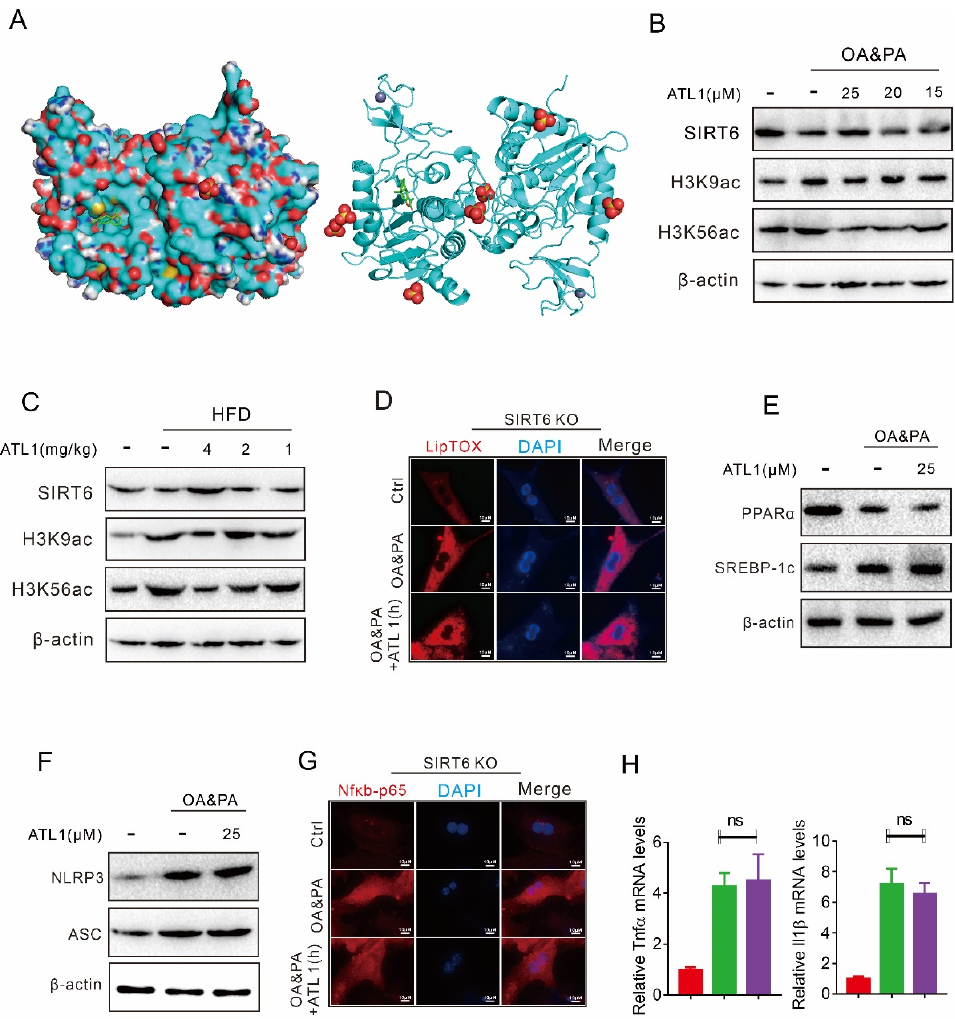
Figure 5. Hepatic SIRT6 mediates the protective effects of ATL I treatment against lipid disorder and inflammation response. ( A ) Molecular docking analysis showed a perfect binding between SIRT6 and ATL I. ( B ) ATL I treatment significantly increased the expression of SIRT6, H3K9ac, and H3K56ac in MPHs. ( C ) ATL I treatment significantly increased the expression of SIRT6, H3K9ac, and H3K56ac in mouse livers. ( D ) LipidTOX assays indicated that ATL I treatment failed to alter the lipid deposition in SIRT6-deficient MPHs. ( E ) ATL I treatment failed to alter the expression of PPAR α and SREBP-1c in SIRT6-deficient MPHs. ( F ) ATL I treatment failed to decrease NLRP3 and ASC protein levels in SIRT6-deficient MPHs. ( G ) ATL I treatment failed to decrease the nuclear Nf κ B-p65 levels in SIRT6-deficient MPHs. ( H ) ATL I treatment failed to decrease the inflammatory genes in SIRT6-deficient MPHs. Results are shown as mean ± SEM (n = 4).